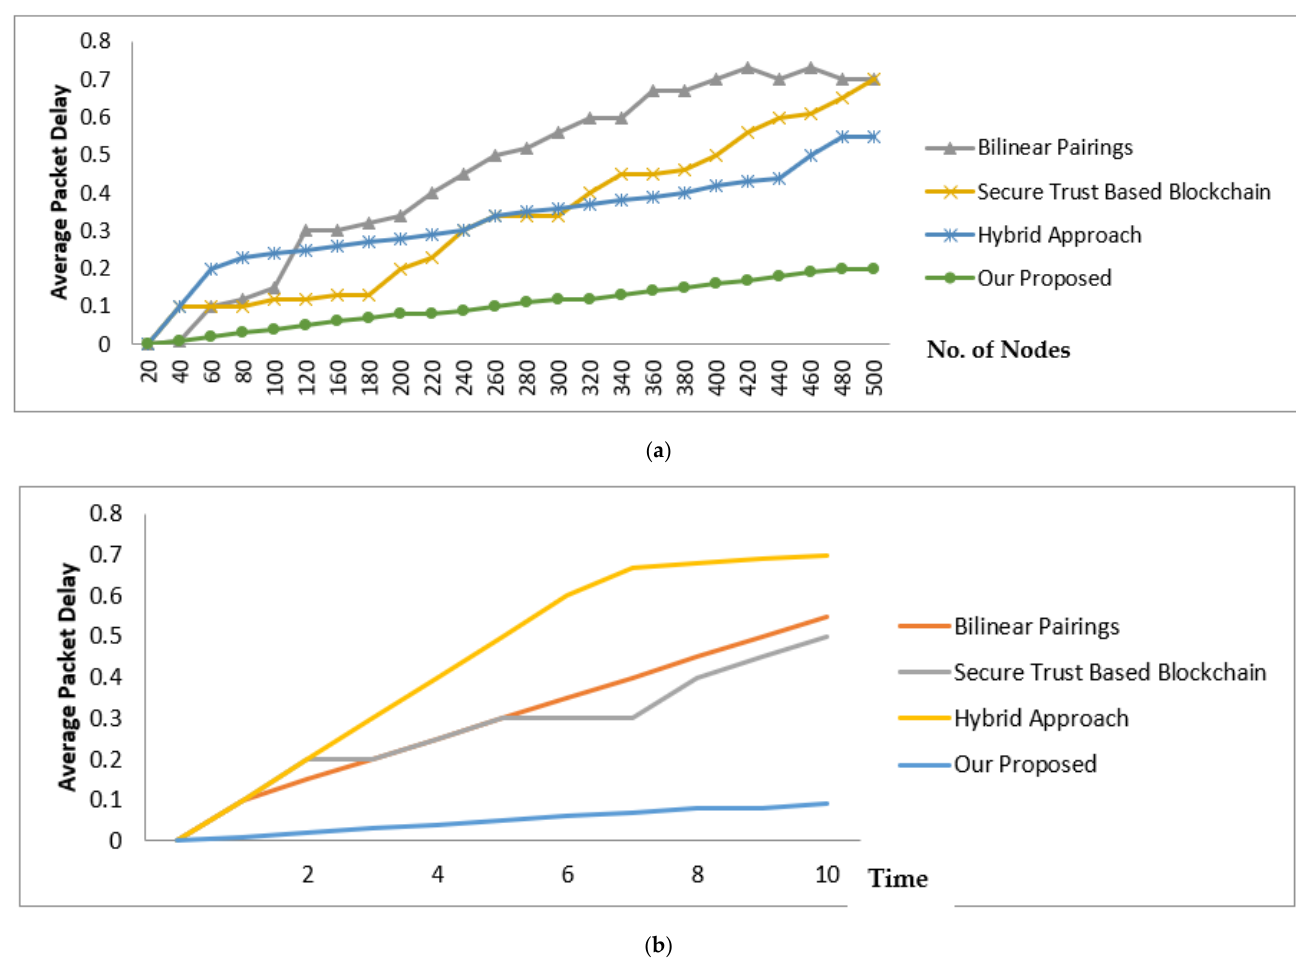
Figure 5. ( a ): Average Packet Delay with DDoS Attack w.r.t No. of Nodes; ( b ): Average Packet Delay with DDoS Attack w.r.t Time.